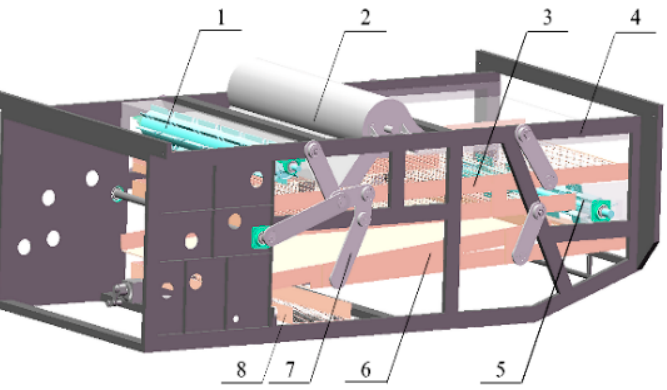
Figure 7. The tuber picking and screening device. 1. Tuber picking drum; 2. Impurity removal blower; 3. Upper combined screen; 4. Rack; 5. Soil-crushing guide roller; 6. Lower combined screen; 7. Linkage; 8. Transverse conveying screen.